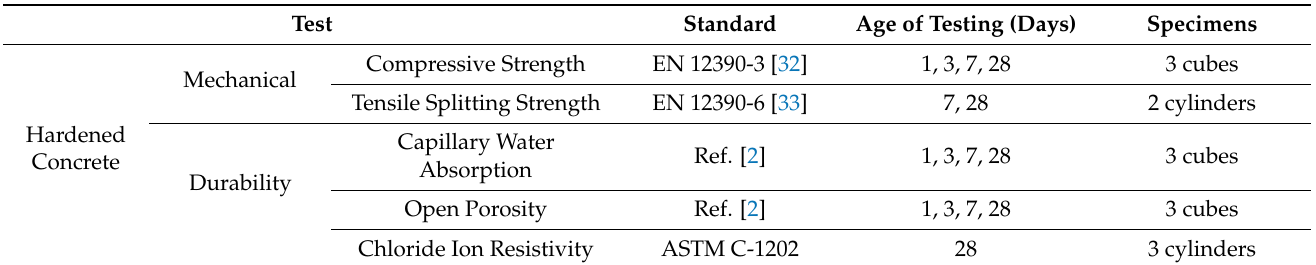
Table 2. Experiments, age of testing, and